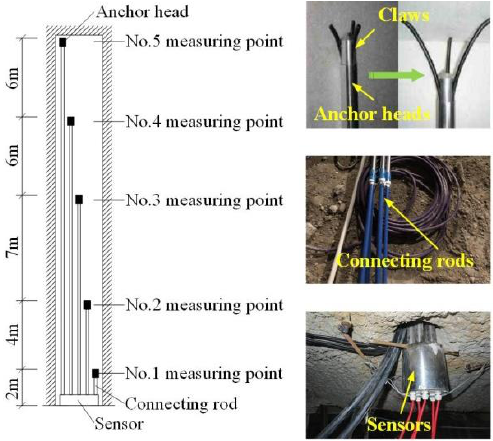
Figure 6. Layout of the multi-point extensometers.